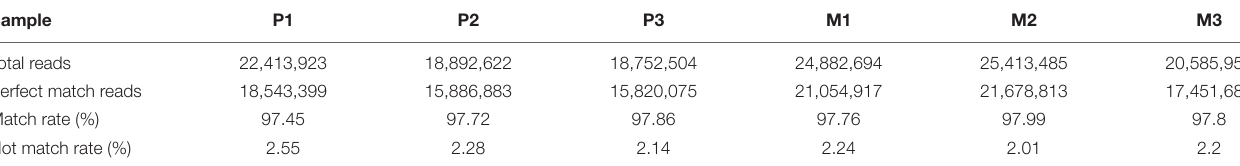
TABLE 2 | Alignment and quantification statistics in each sample miRNA library.